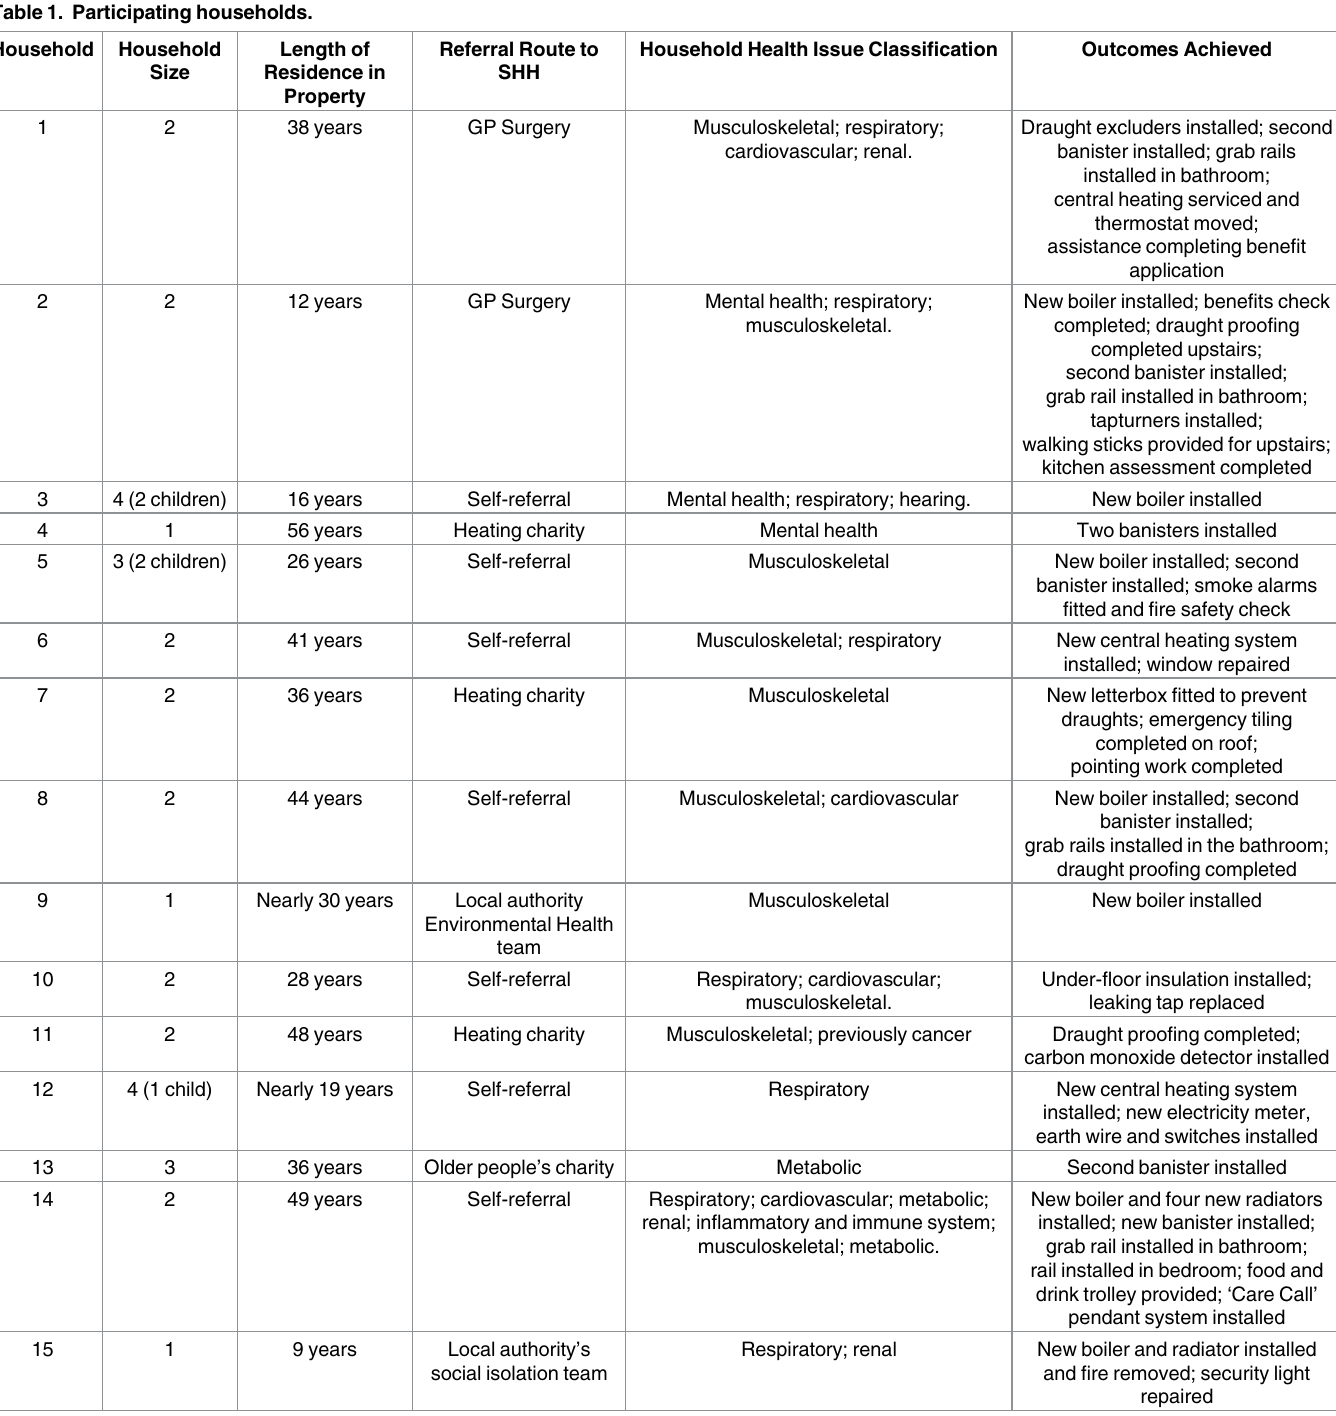
Table 1. Participating